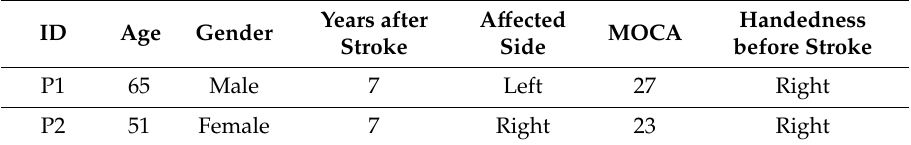
Table 2. Demographic